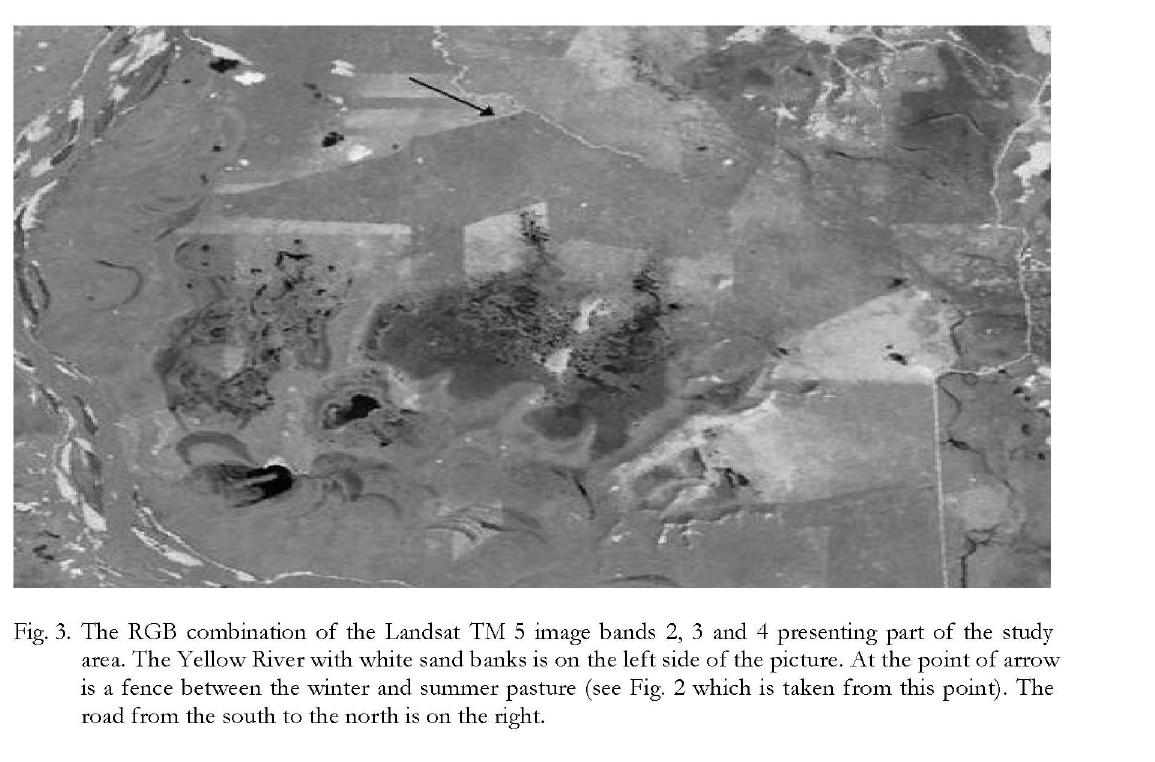
Fig. 3. The R GB combination of the Landsat TM 5 image bands 2, 3 and 4 presenting part of the study area. The Yellow River with white sand banks is on the left side of the picture. At the point of arrow is a fence between the winter and summer pasture (see Fig. 2 which is taken from this point). The road from the south to the north is on the right.